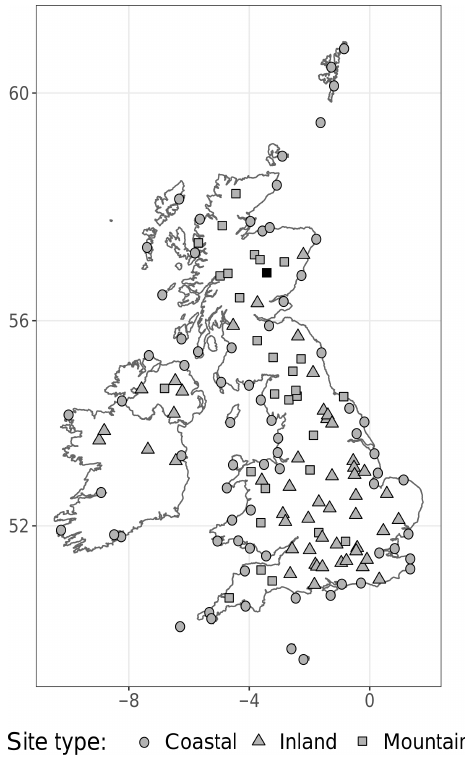
Figure 1. Map of the British Isles with the 152 observation loca- tions used in this study. The sites are divided into three categories, coastal, inland and mountain sites, depending on their location and altitude. The black square marks The Cairnwell, a mountainous site in the Scottish